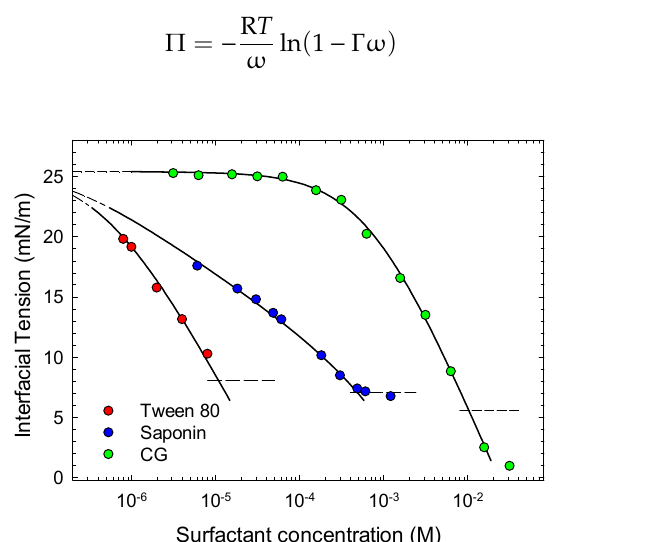
Figure 4. Equilibrium interfacial tension versus molar surfactant concentration in water (for saponin calculated assuming 1650 g/mol as molar weight) and respective best fit isotherm curves (Equations (3)–(5)). Table 1. Adsorption isotherm parameters corresponding to the best fit curves reported in Figure 4 and critical micellar concentration, cmc.